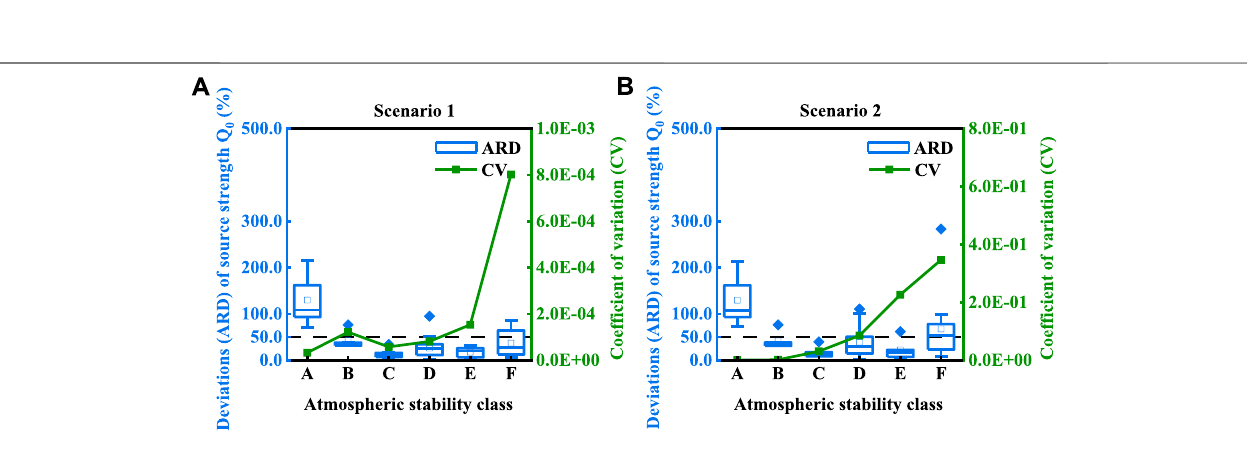
Frontiers in Environmental Science |